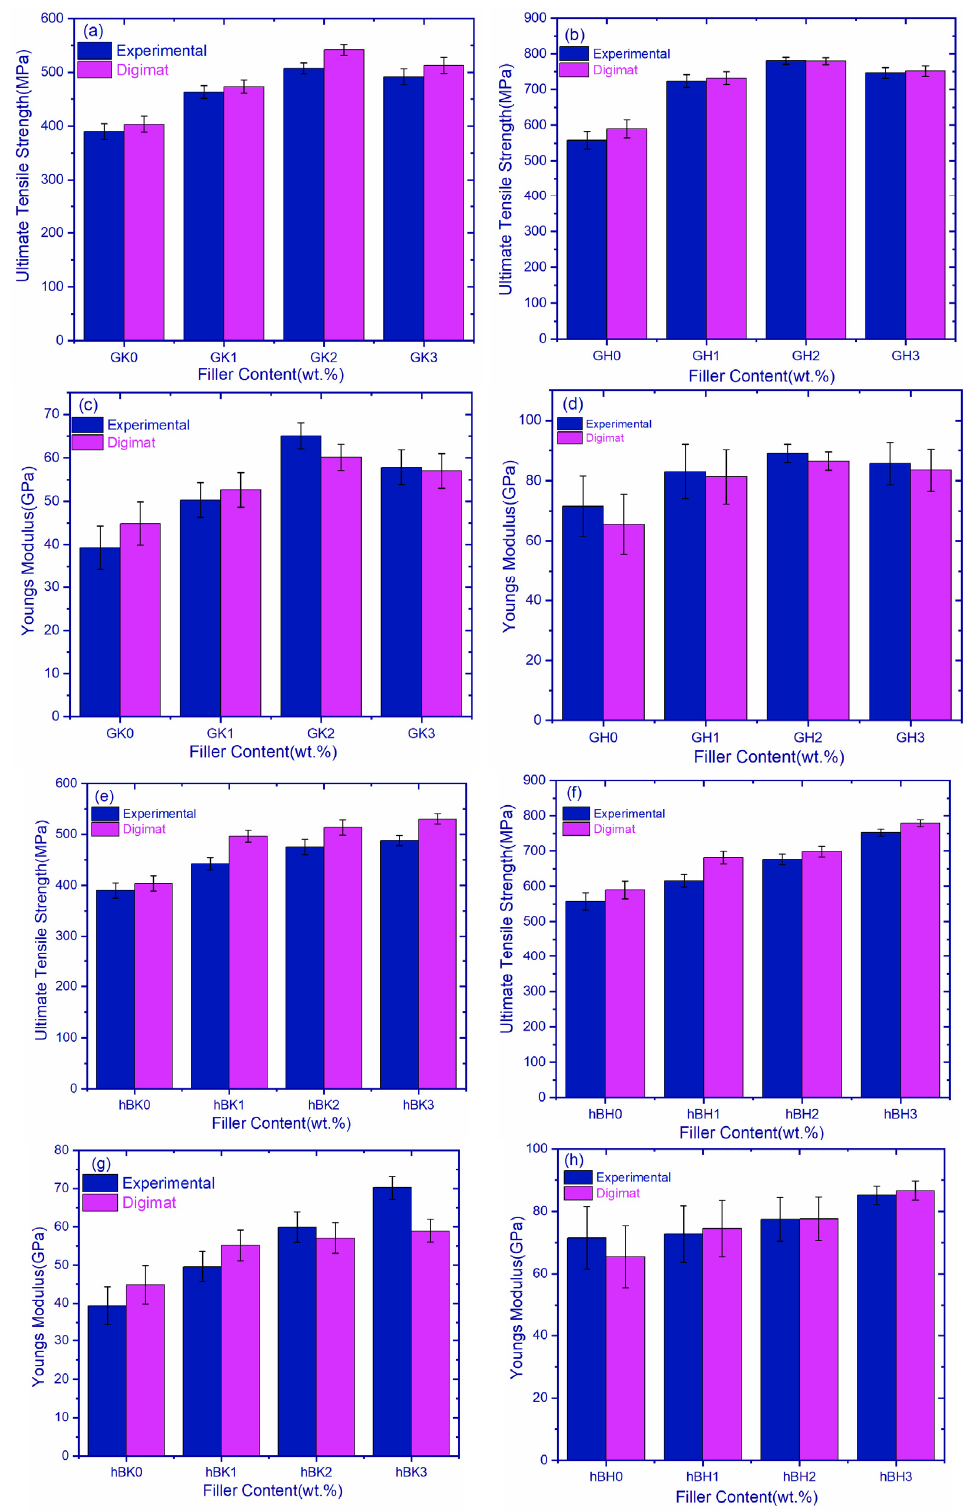
Figure 5. Comparison of experimental Digimat graphene-reinforced composite system—( a ) UTS of Kevlar composites, ( b ) UTS of hybrid composites, ( c ) Young’s modulus of Kevlar composites, ( d ) Young’s modulus of hybrid composites; and comparison of experimental Digimat hBN-reinforced composite systems—( e ) UTS of Kevlar composites, ( f ) UTS of hybrid composites, ( g ) Young’s modulus of Kevlar composites, ( h ) Young’s modulus of hybrid composites .